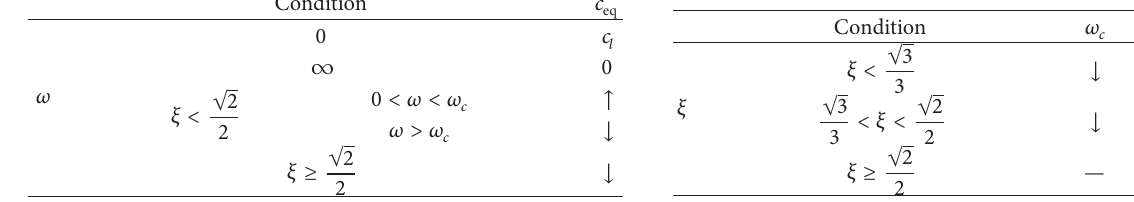
Table 3: Rule by which 𝑐 changes with 𝜔 . Table 4: Rule by which 𝜉 affects the key points of the equivalent eq damping